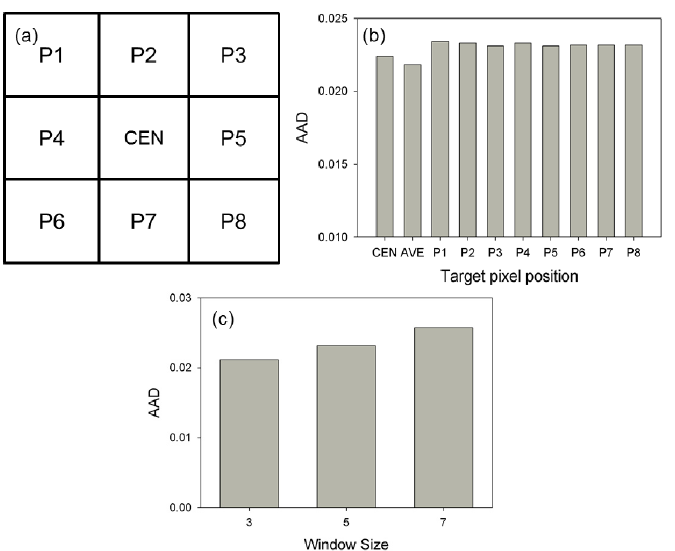
Figure 15. ( a ) The MODIS pixels within a moving window used to solve a linear model system, CEN indicates the center of the moving window. ( b ) The performance comparison by using different growth rates estimated from different positions of a moving window. Here, AVE stands for averaged growth rate of all growth rates. ( c ) The AAD comparison using different window